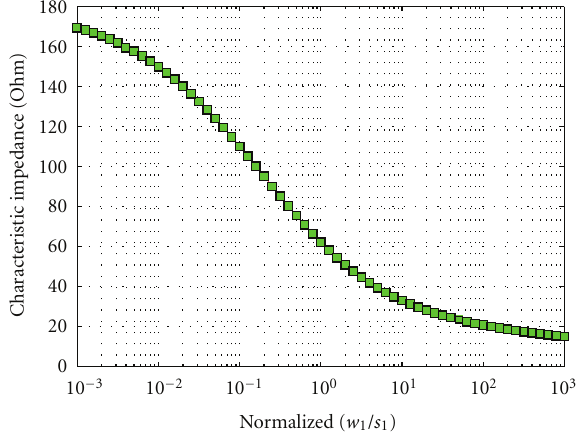
Figure 7: Characteristic Impedance of the CPW for the case of ε r = 10 . 2 versus normalized w 1 /s 1 ratio on logarithmic